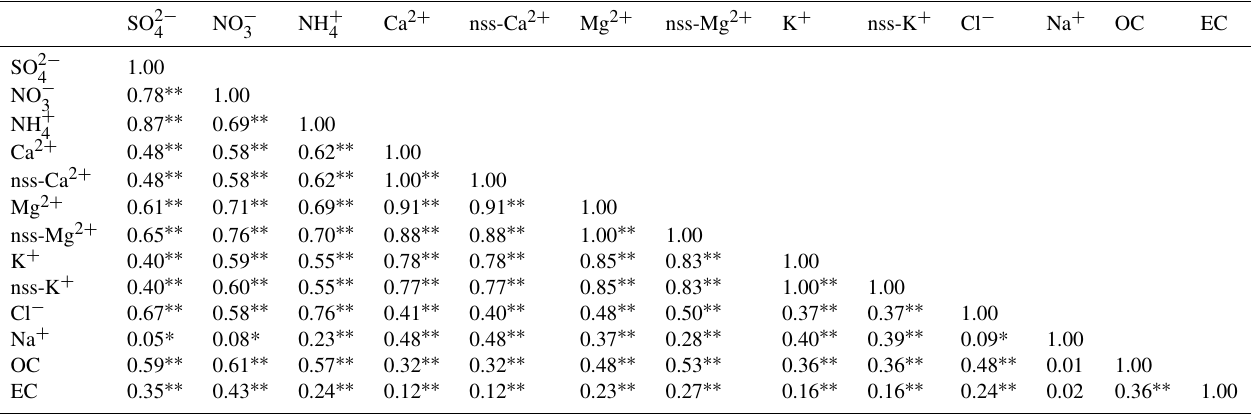
Table 2. Linear correlation coefficients ( R 2 ) among major ions and OC and EC in aerosols in Bode, Kathmandu Valley. SO 2 − NO − NH + Ca 2 + nss-Ca 2 4 3 4